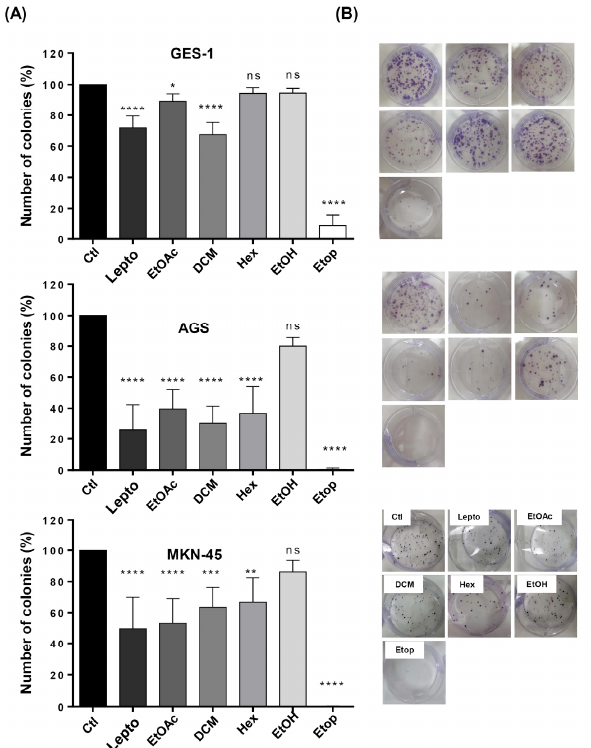
Figure 3. Effect of L. rivularis flower extracts on the clonogenic potential of gastric cells. Synchronized GES-1, AGS, and MKN-45 cells were treated with L. rivularis flower extracts (DCM 5 µ g/mL, EtOAc 5 µ g/mL, Hex 10 µ g/mL, or EtOH 15 µ g/mL), Etop 50 µ M (Etop) or leptocarpin (Lepto) 5 µ g/mL for 24 h. Then, the clonogenic potential of gastric cells was evaluated as described in the Material and Methods section. ( A ) Bars represent the percentage of colonies formed in response to the different treatments, compared with the control condition (means ± S.D., n = 3, * p < 0.05, ** p < 0.01, *** p ≤ 0.001, and **** p ≤ 0.0001, ns: non-significant). ( B ) Representative images of the clonogenic assay in GES-1, AGS, and MKN-45 cells treated with the extracts, leptocarpin, or Etoposide in standard 6-well